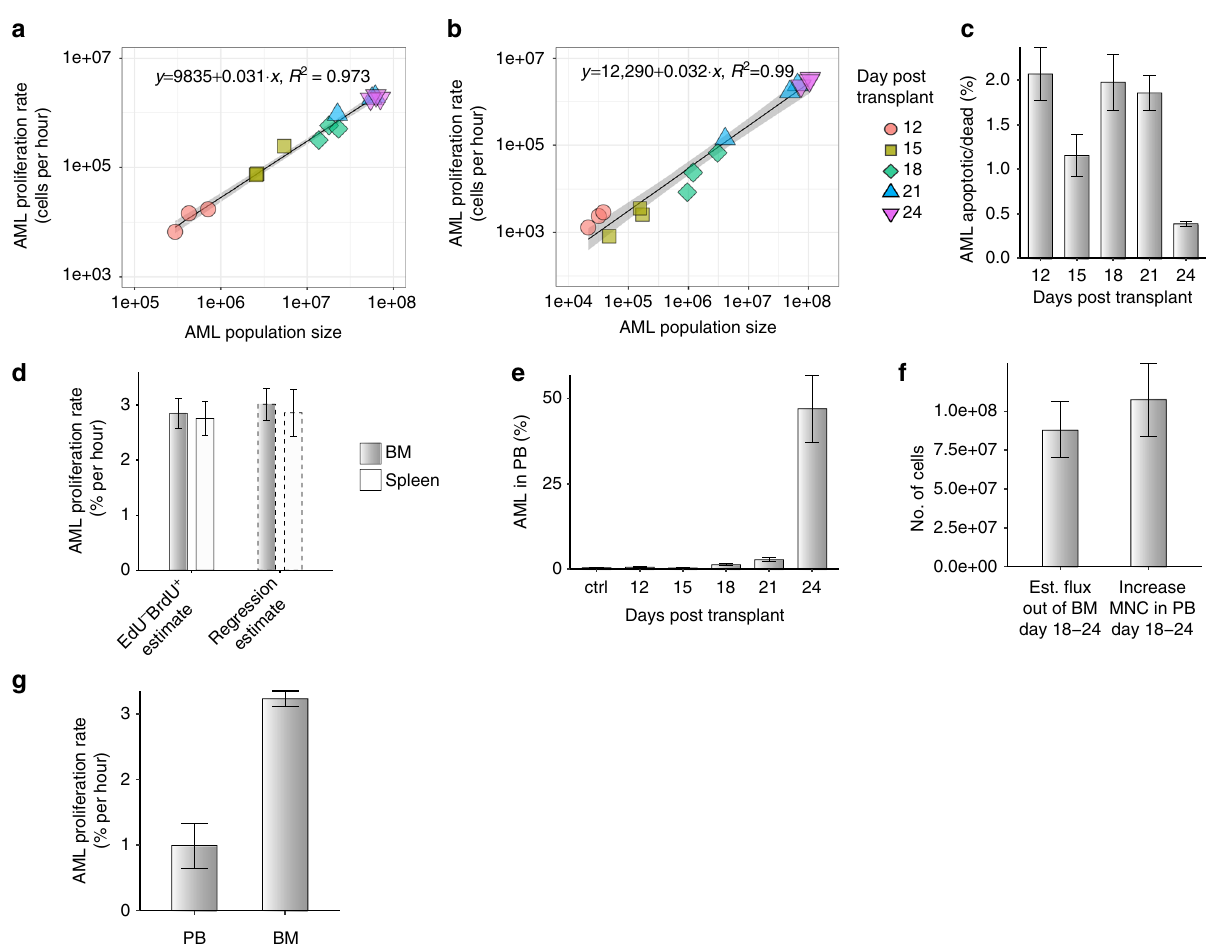
Fig. 3 Proliferation and BM egression dynamics of AML cells. Number of AML cells entering S phase per hour in BM ( a ) and spleen ( b ) are plotted against absolute numbers of AML cells in tibea, femur and ileac crest bones of mice at multiple time points following injection of AML blasts (colour and shape coded). Black lines are linear regression of the data, with con fi dence intervals in grey. c Very small proportions of apoptotic cells (DAPI and/or Annexin V positive) are detectable within the AML cell population throughout disease progression (average ± s.e.m shown; days 15 and 24, p = 0.07, Welch two- sample t -test; n = 3 mice at each time point). d Proportion of AML cells entering S phase per hour estimated for BM (grey bars) and spleen (white bars) using dual-pulse method (left) and exponential regression from data presented in Fig. 1b and Supplementary Fig. 1 (average ± s.e.m; BM vs. spleen EdU − BrdU + estimates p = 0.8208, Welch two-sample t -test; n = 9 mice). e The proportion of AML cells in PB (RBC lysed) increases slowly following injection of blasts, and dramatically by the late stages of the disease (average ± s.e.m; n = 3 mice per time point). f Comparison of estimated number of AML cells exiting BM between days 18 and 24, and measured increase in MNCs in blood during those days (average ± bootstrap std. deviation shown for estimate, average ± s.e.m shown for measured values; estimate, n = 6 samples based on measurements presented in Figs. 1b and 3a; measured PB MNC, n = 6 mice). g Proportion of AML cells entering S phase per hour in blood and BM (average ± s.e.m shown; p = 0.0003, Welch two-sample t -test; n = 3 and